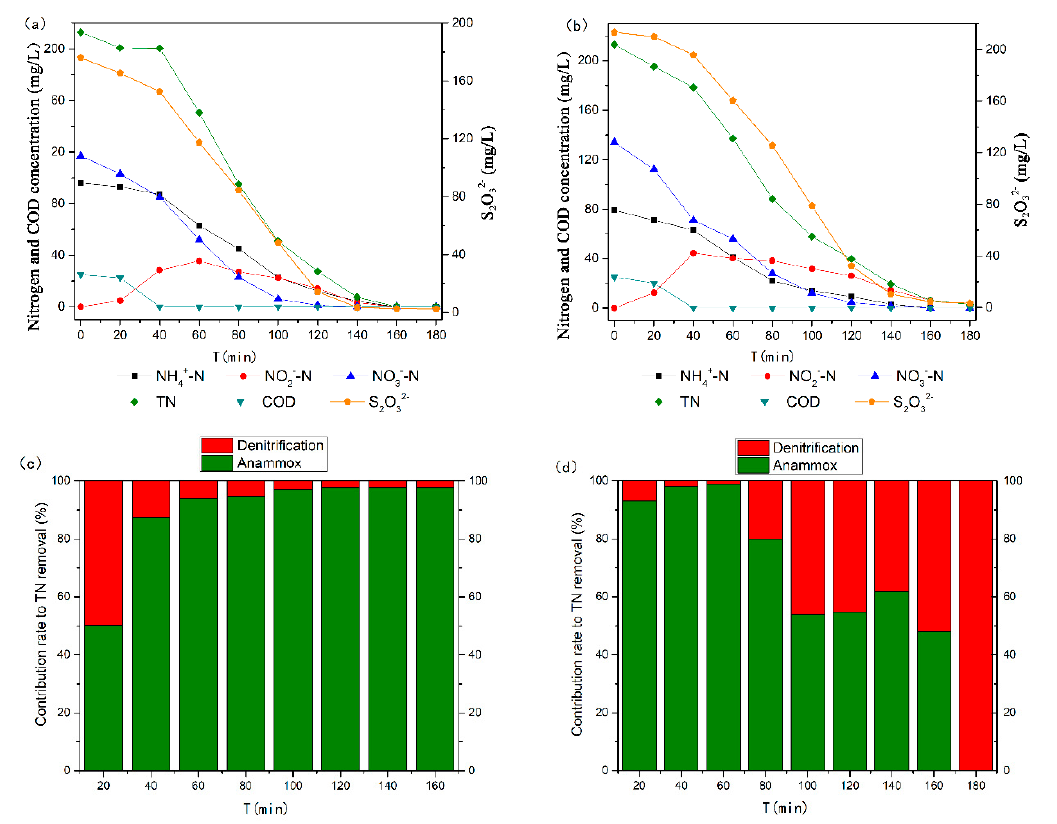
Figure 4. Nitrite accumulation efficiency (NAE) and contribution rate of anammox and denitrification to total nitrogen (TN) removal.